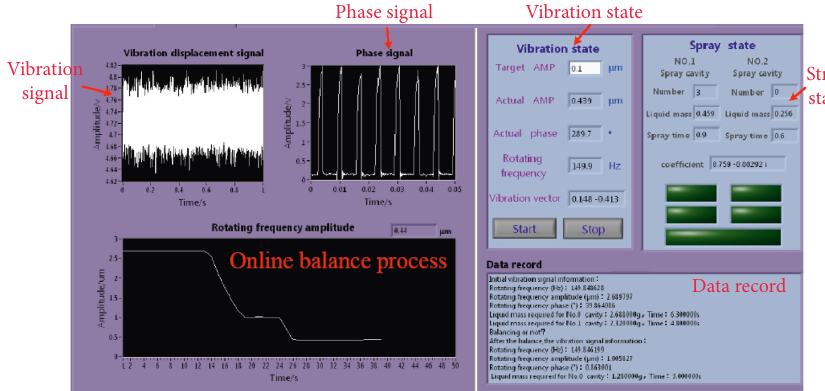
Figure 16: Measurement and control panel.